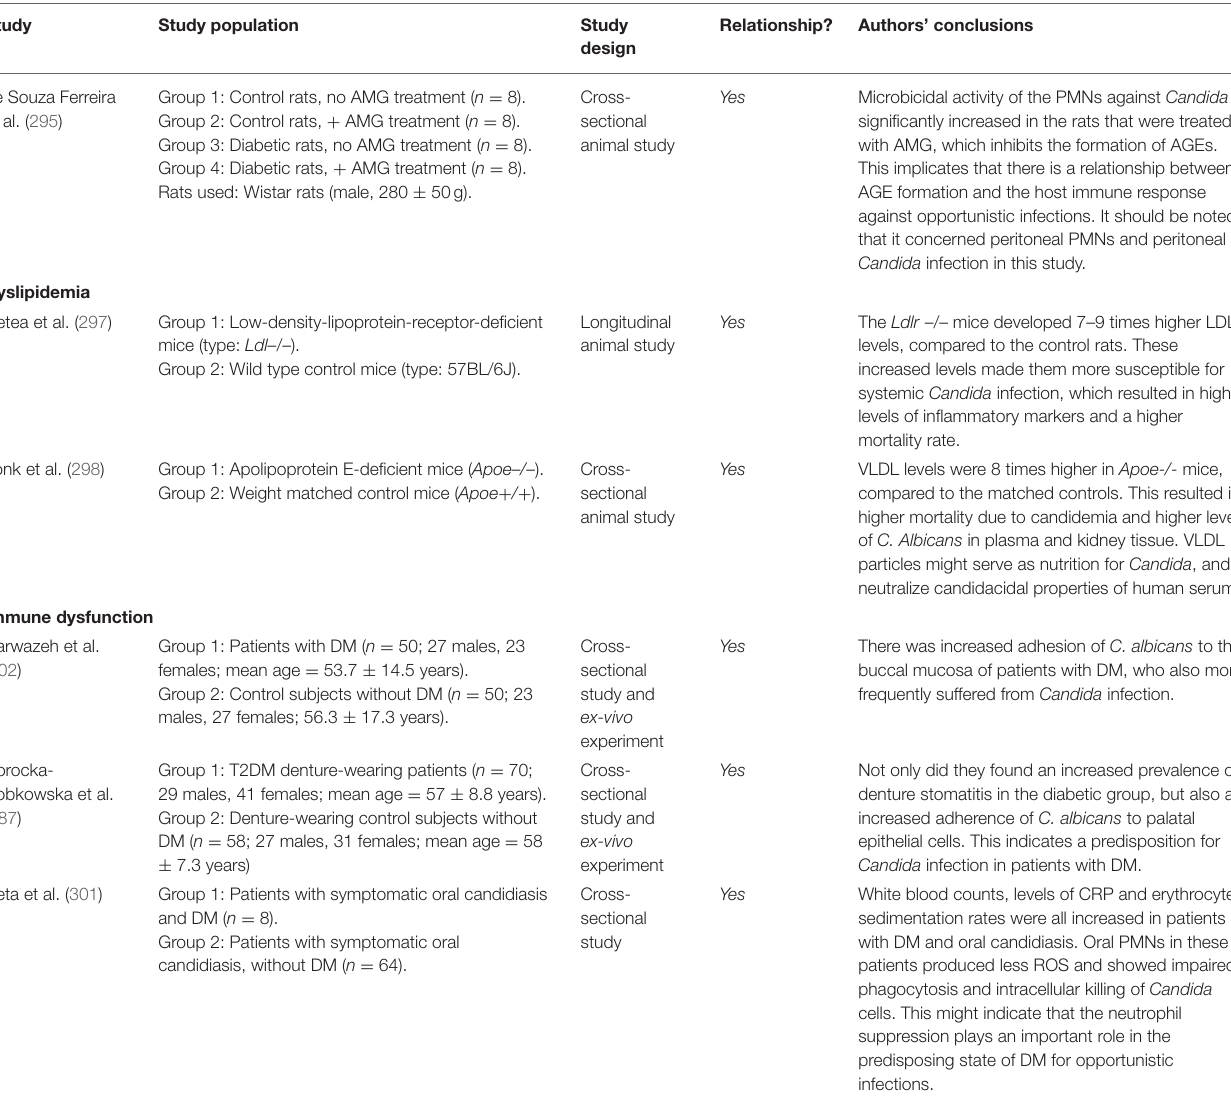
Yes Cross- sectional study and ex-vivo experiment Yes Not only did they found an increased prevalence of Cross- denture stomatitis in the diabetic group, but also an sectional increased adherence of C. albicans to palatal study and ex-vivo epithelial cells. This indicates a predisposition for Candida infection in patients with DM. experiment Cross- sectional study